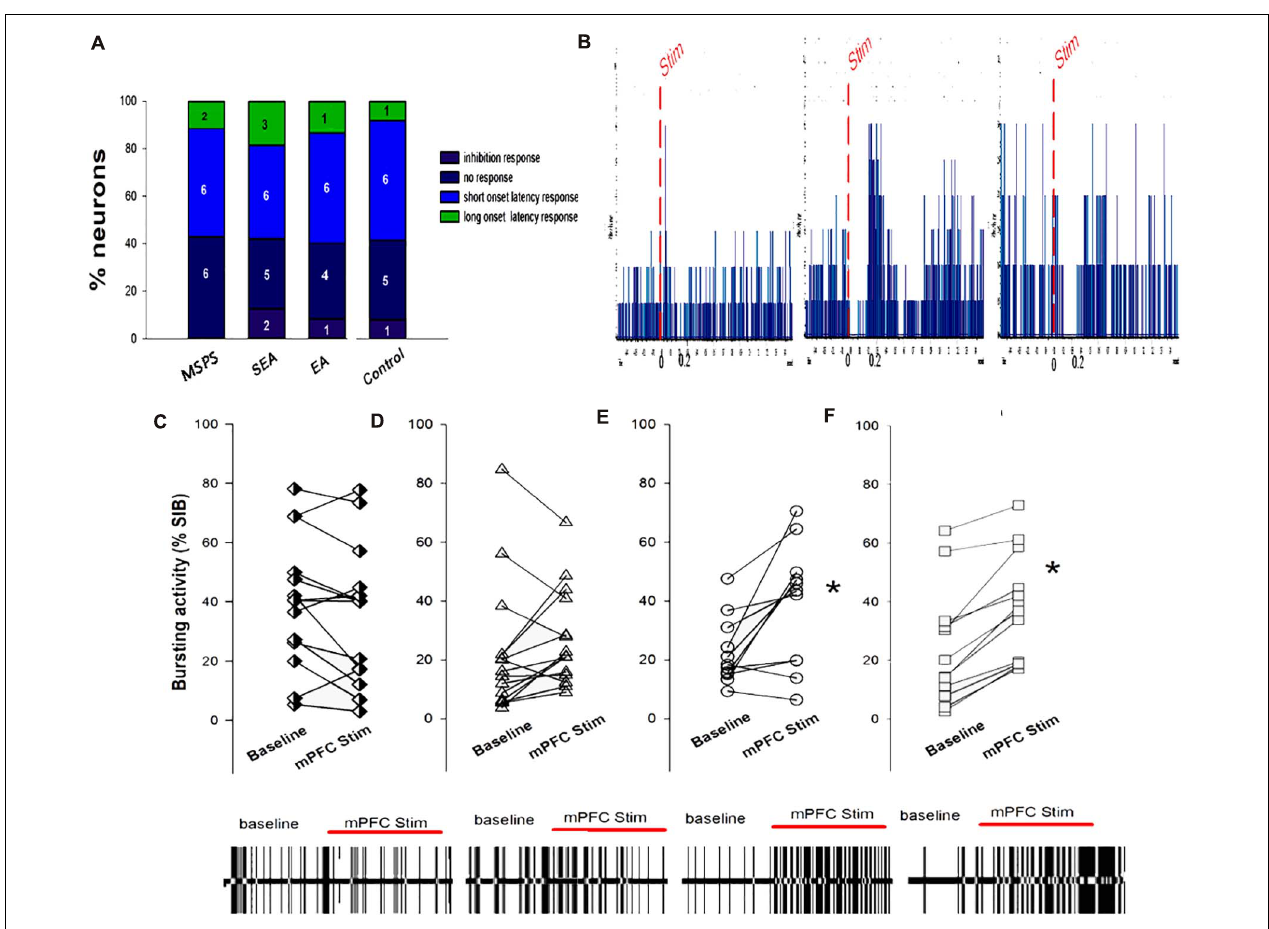
FIGURE 7 | The association between MSPS and EA treatment VTA DA neuron responses to vmPFC electrical stimulation. (A) VTA DA neuron response types in response to vmPFC stimulation in the indicated treatment groups. (B) Representative DA neuron short-latency excitatory responses (left), long-latency excitatory responses (middle), and inhibition responses (right) following vmPFC stimulation (50 pulses, 0.5 Hz). (C–F) VTA DA neuron bursting activity (%SIB) of VTA DA at baseline and upon vmPFC stimulation. (C) PTSD group; (D) SEA group; (E) EA group; (F) Control group. PTSD and SEA rats exhibiting no differences in %SIB between eight baseline and vmPFC stimulation, whereas %SIB rose relative to baseline upon vmPFC stimulation in EA and control rats. * P < 0.05, vs.